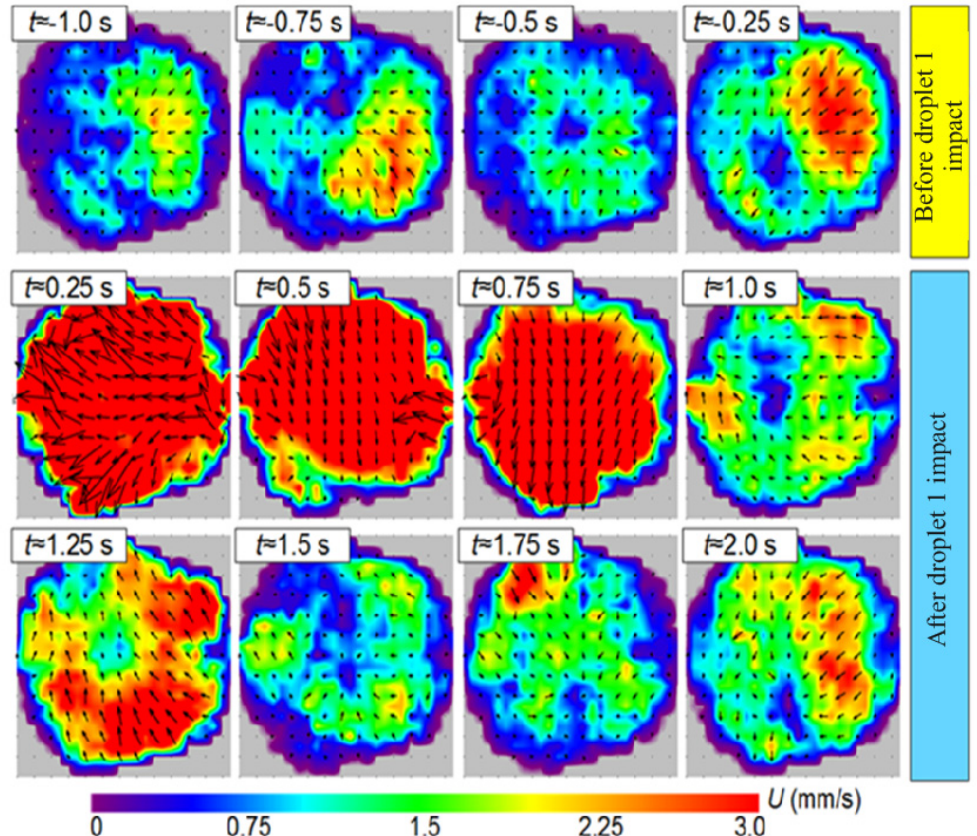
Figure 9. Velocity field in horizontal section of drop 2; V 01 = 2.5 µ L; V 02 = 40 µ L; T w = 80 ◦ C; T 01 = 20 ◦ C; water (droplet 1) + water (drop 2).